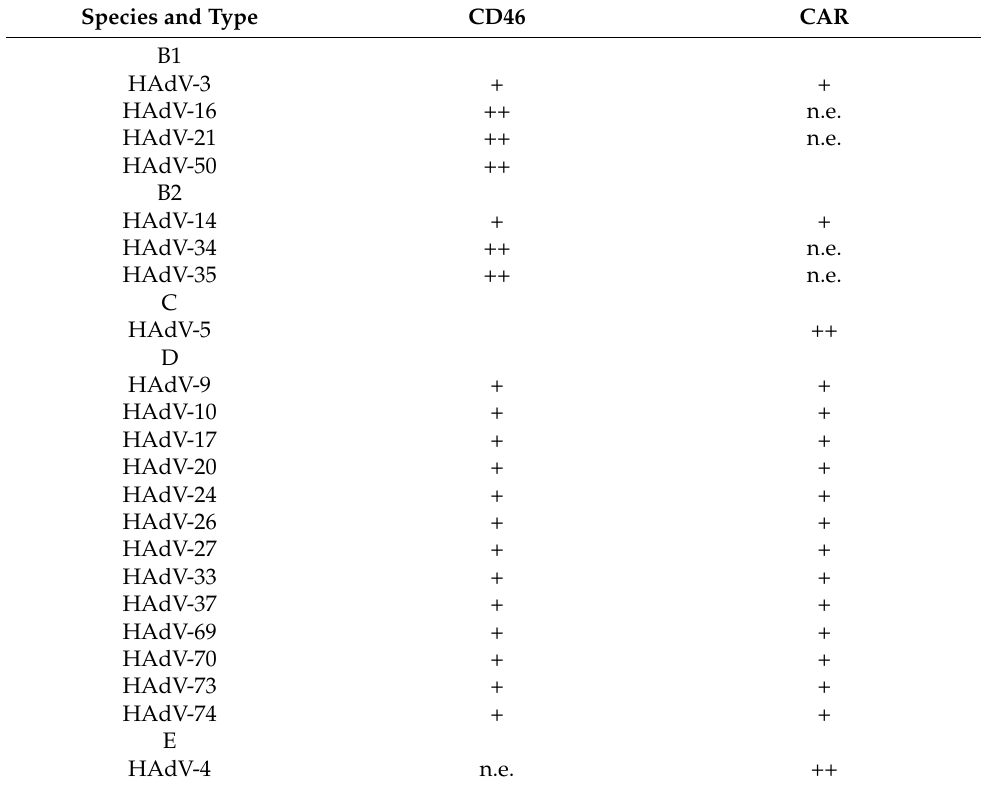
Table 1. Receptor usage by adenoviral types from species B to